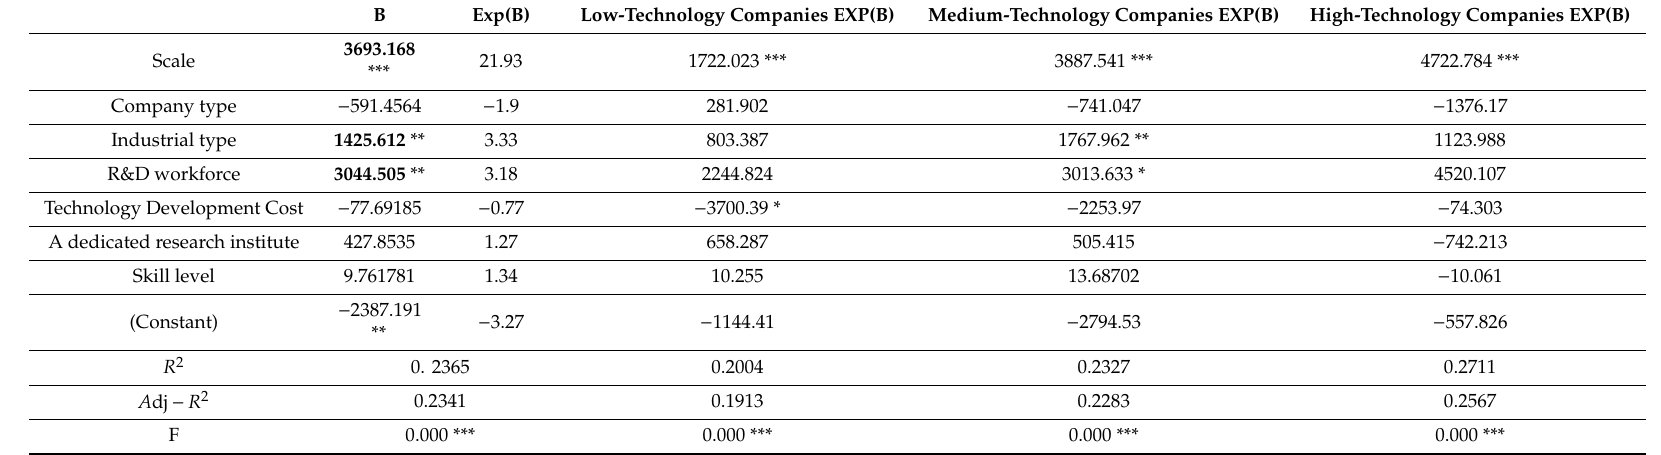
Table 6. Regression analysis result on sales of technology commercialization.